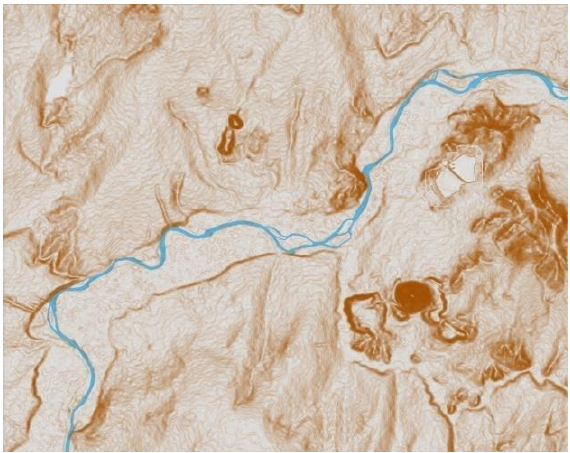
Figure 2. The topography of the simulated area. The size of the simulated area 21×19 km. The contour interval is 0.5 m.